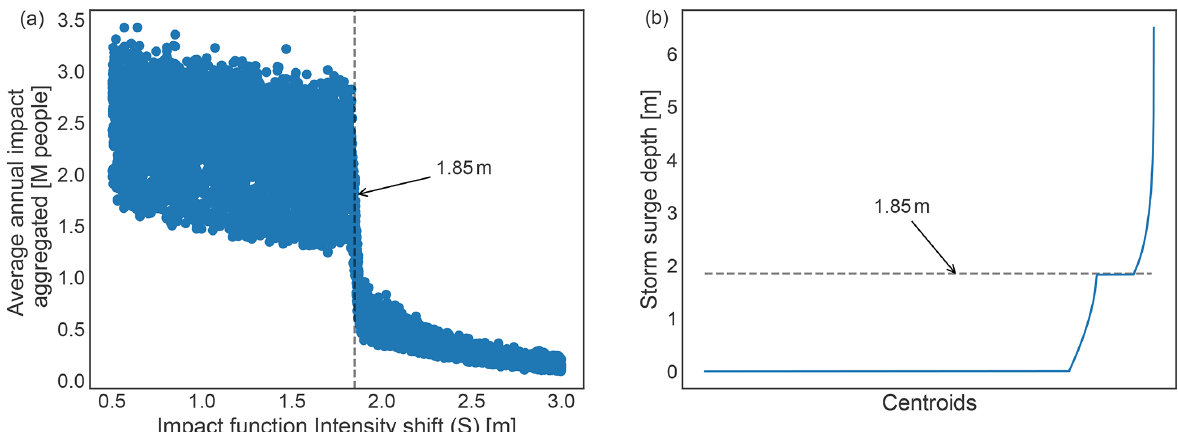
Figure D5. (a) Annual average impact averaged over all exposure points in millions (M) of affected people as a function of the impact function threshold shift uncertainty ( S ) in metres (m), and (b) storm surge intensity in metres (m) of all events at each location (centroid) from the original case study. A nonlinear change in intensity at ∼ 1 . 85m is indicated by a dashed